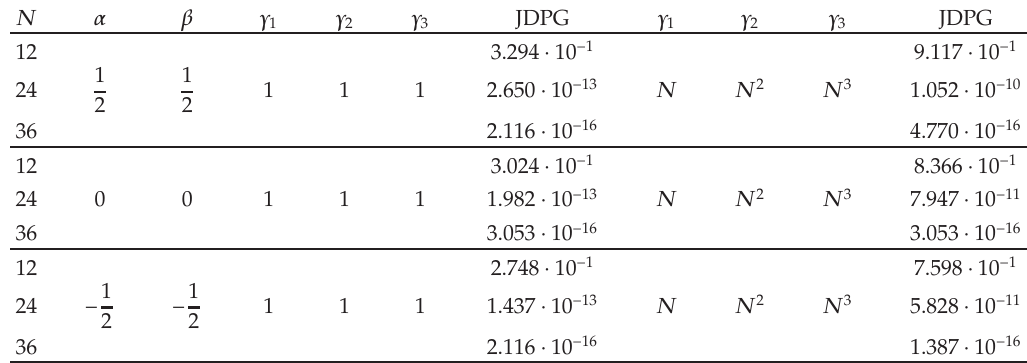
Table 2: Maximum pointwise error using JDPG method for N (cid:6) 12 , 24 , 36, for Example 5.2. N α β γ 1 γ 2